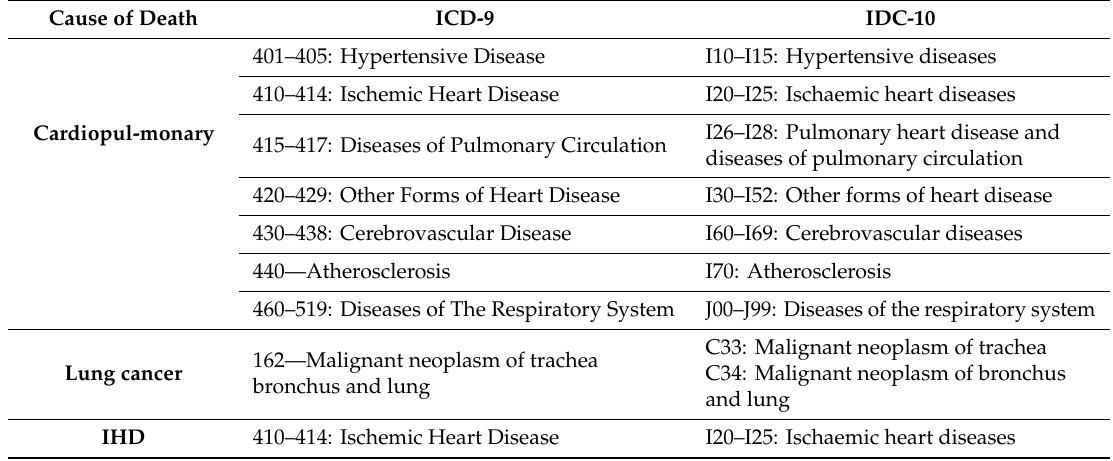
Table 4. Disease classification codes in ICD-9 and ICD-10.